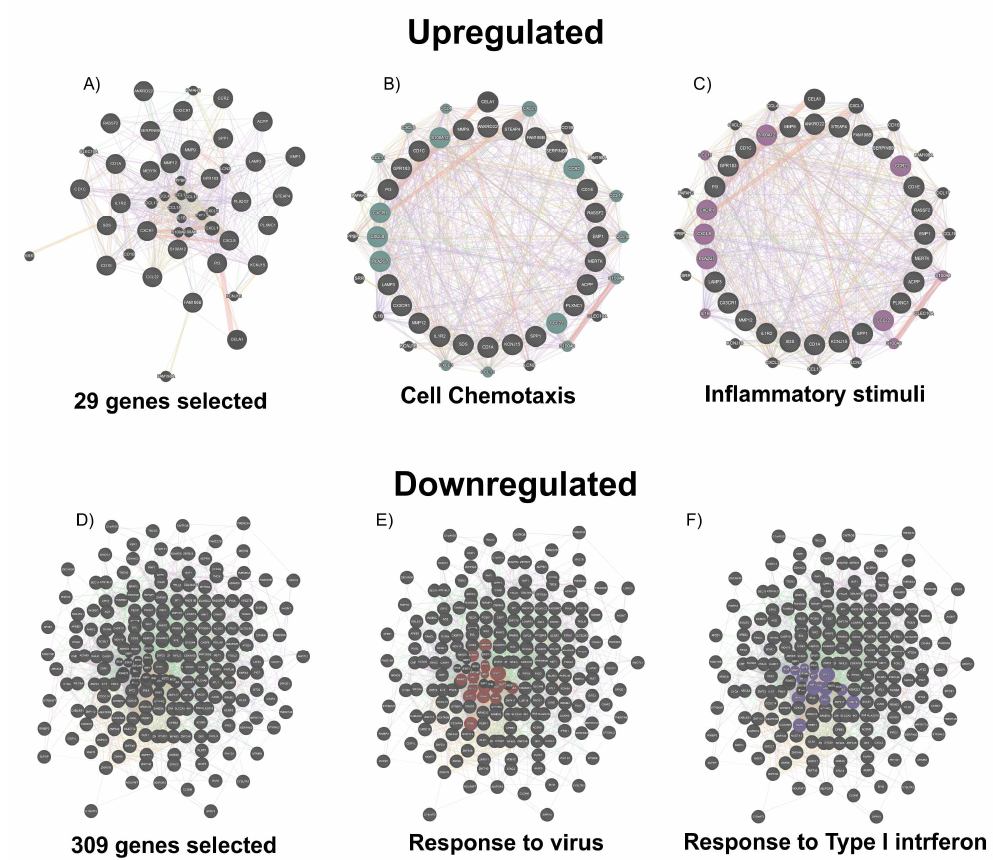
Figure 2. The GeneMania network representation of the 29 upregulated and 309 downregulated genes: ( A ) The GO analysis of 29 genes involved during the exposition to a high ppb of ozone expresses ( B ) the cell chemotaxis and ( C ) inflammatory stimuli as biological processes. ( D ) The 309 downregulated genes in subjects exposed to a high ppb of ozone belong to the biological processes as a response to ( E ) the virus and to ( F ) Type I interferon.